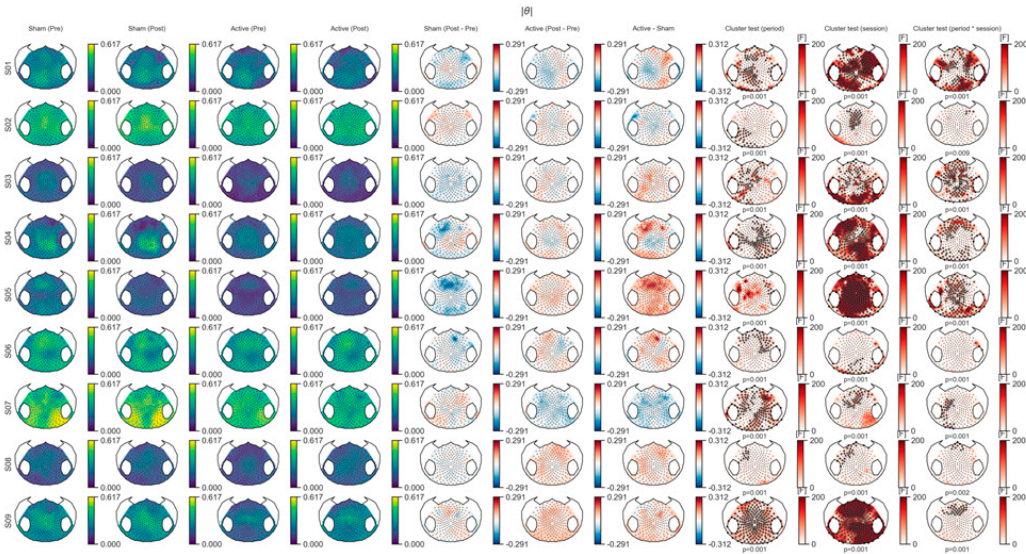
Figure A2. Spectral Power Variability of the Theta Band at the Subject Level. The first four columns show the mean power over the epochs for each session and period. Columns 5 and 6 show the power difference in the sham and active sessions, respectively. Column 7 shows the difference between active and sham sessions (i.e., (post-pre) Active– (post-pre) sham ). Columns 8 to 10 show the results of the permutation cluster test on the F values of the ANOVA model to test the significance of the effects of period (post vs. pre), session (sham vs. active), and their interaction, respectively.